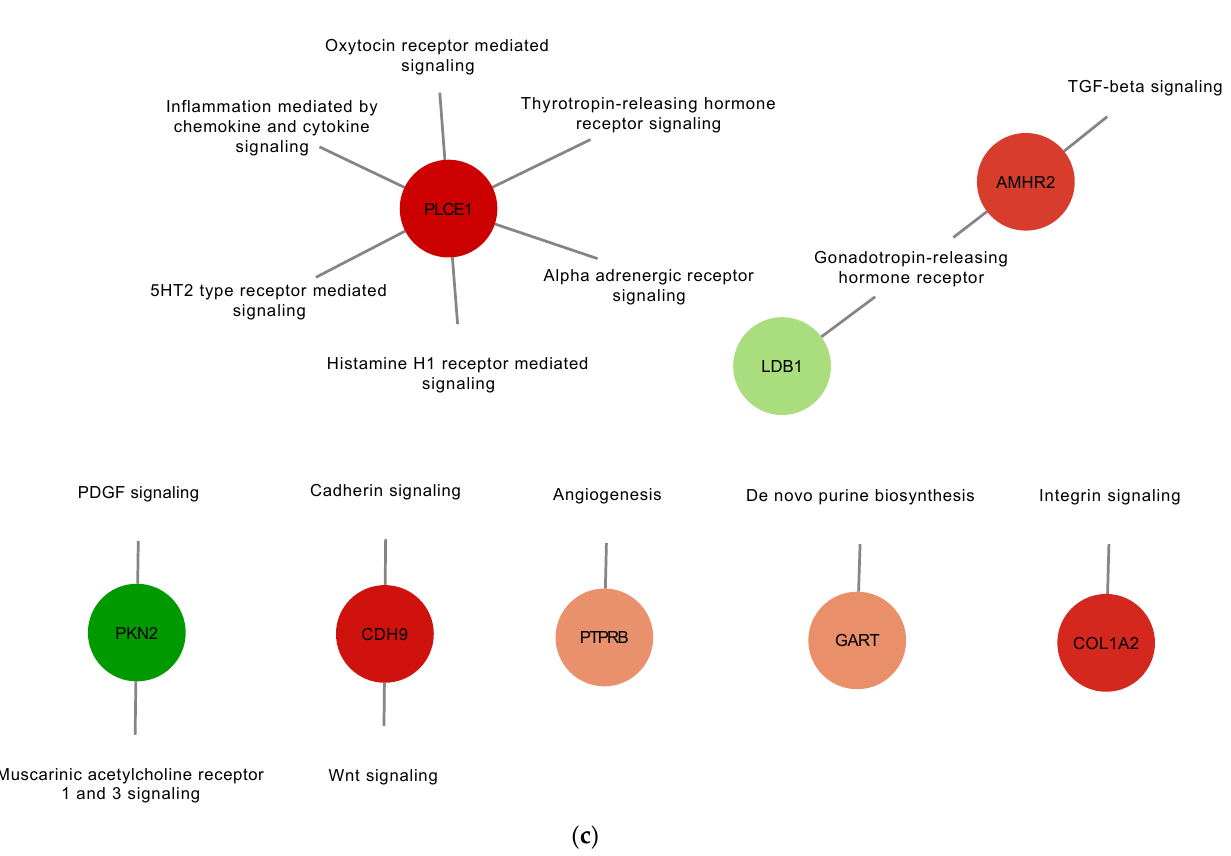
Figure 4. Gene set enrichment analysis of up-regulated and down-regulated proteins of EVs from TOCs treated with AIV ( a ), LPS ( b ), and polyI:C ( c ). Functional annotation for selected pathways was obtained from the PANTHER classification system database. Pathway enrichment results are shown as a network with nodes colored based on relative abundance (compared to EV control treatment group). Selected up-regulated proteins are shown in green, whereas down-regulated proteins are shown in red. The complete lists of up- and down-regulated proteins for AIV, LPS, and polyI:C treatment groups are shown in Table S4.